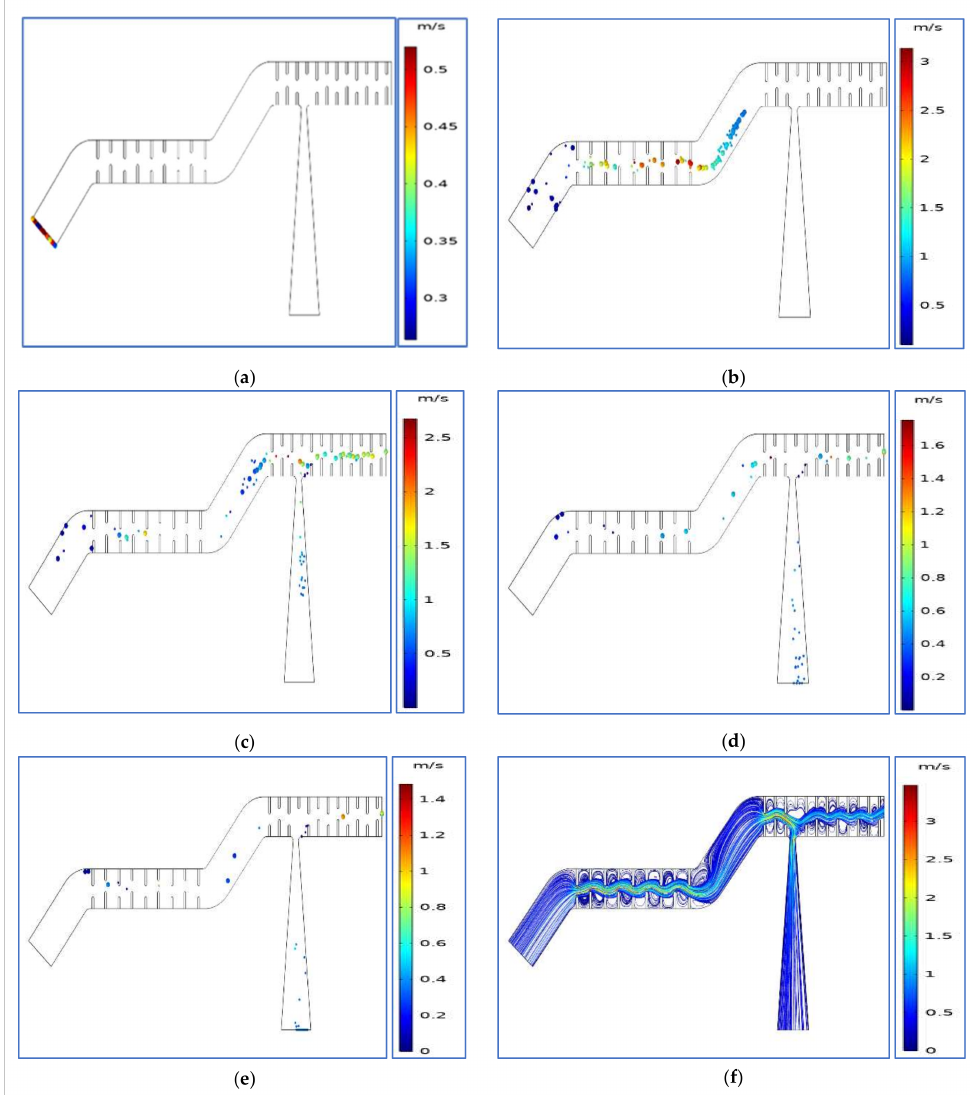
Figure 9. Fluid-particle interaction results of cilia microchip at 0–0.021 s and velocity